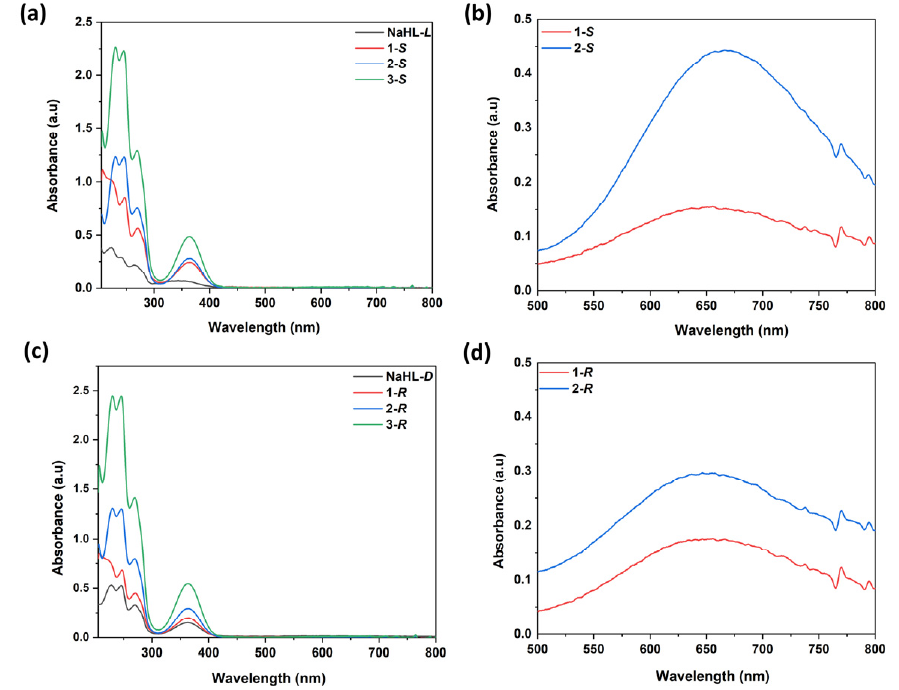
Figure 5. ( a ) UV-vis spectra of NaHL- S , 1- S , 2 -S , 3- S in methanol with concentrations of 2.5 × 10 − 5 Figure